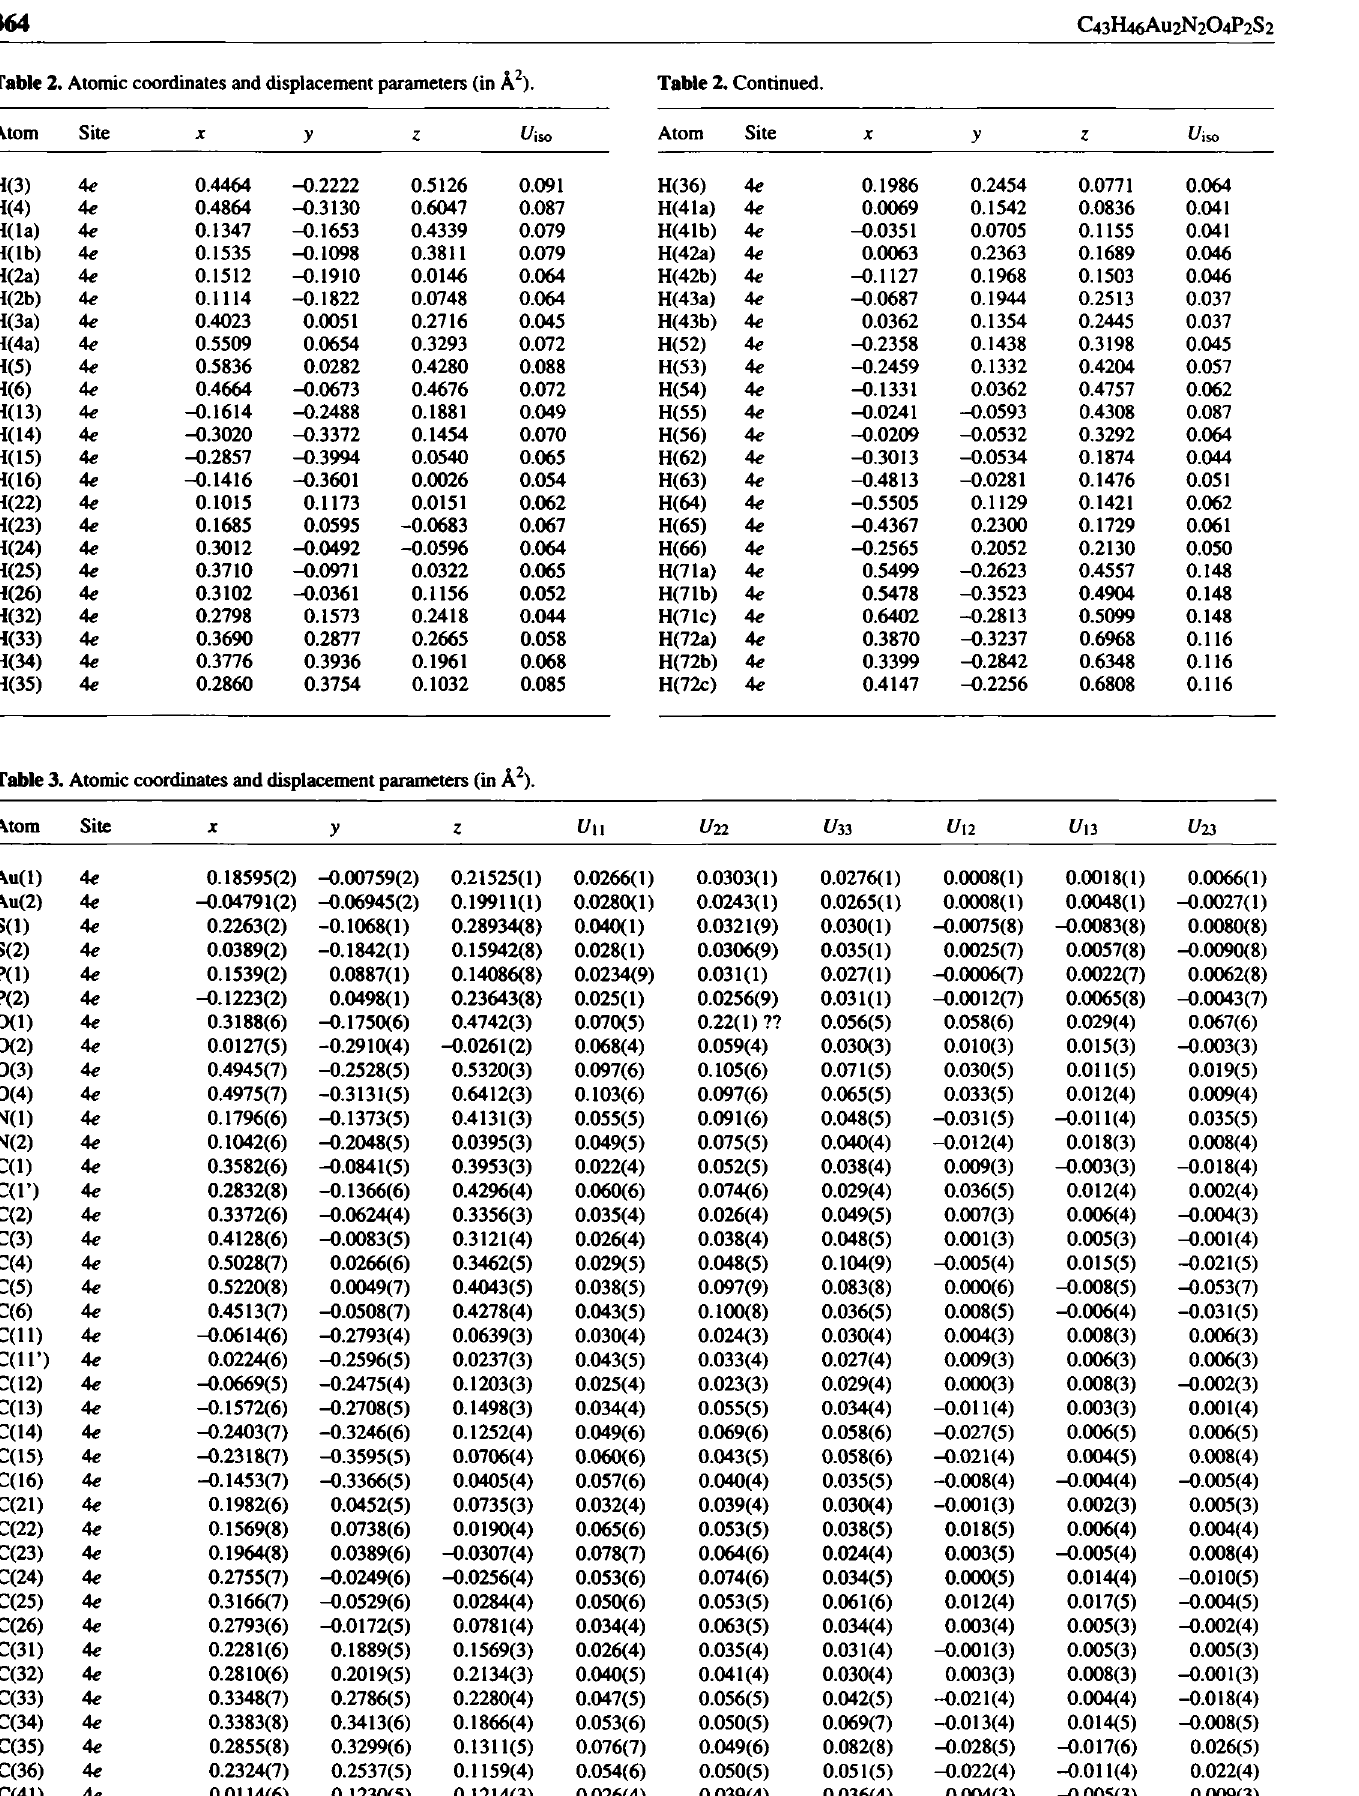
Tabic 2. Atomic coordinates and displacement parameters (in À 2 ).